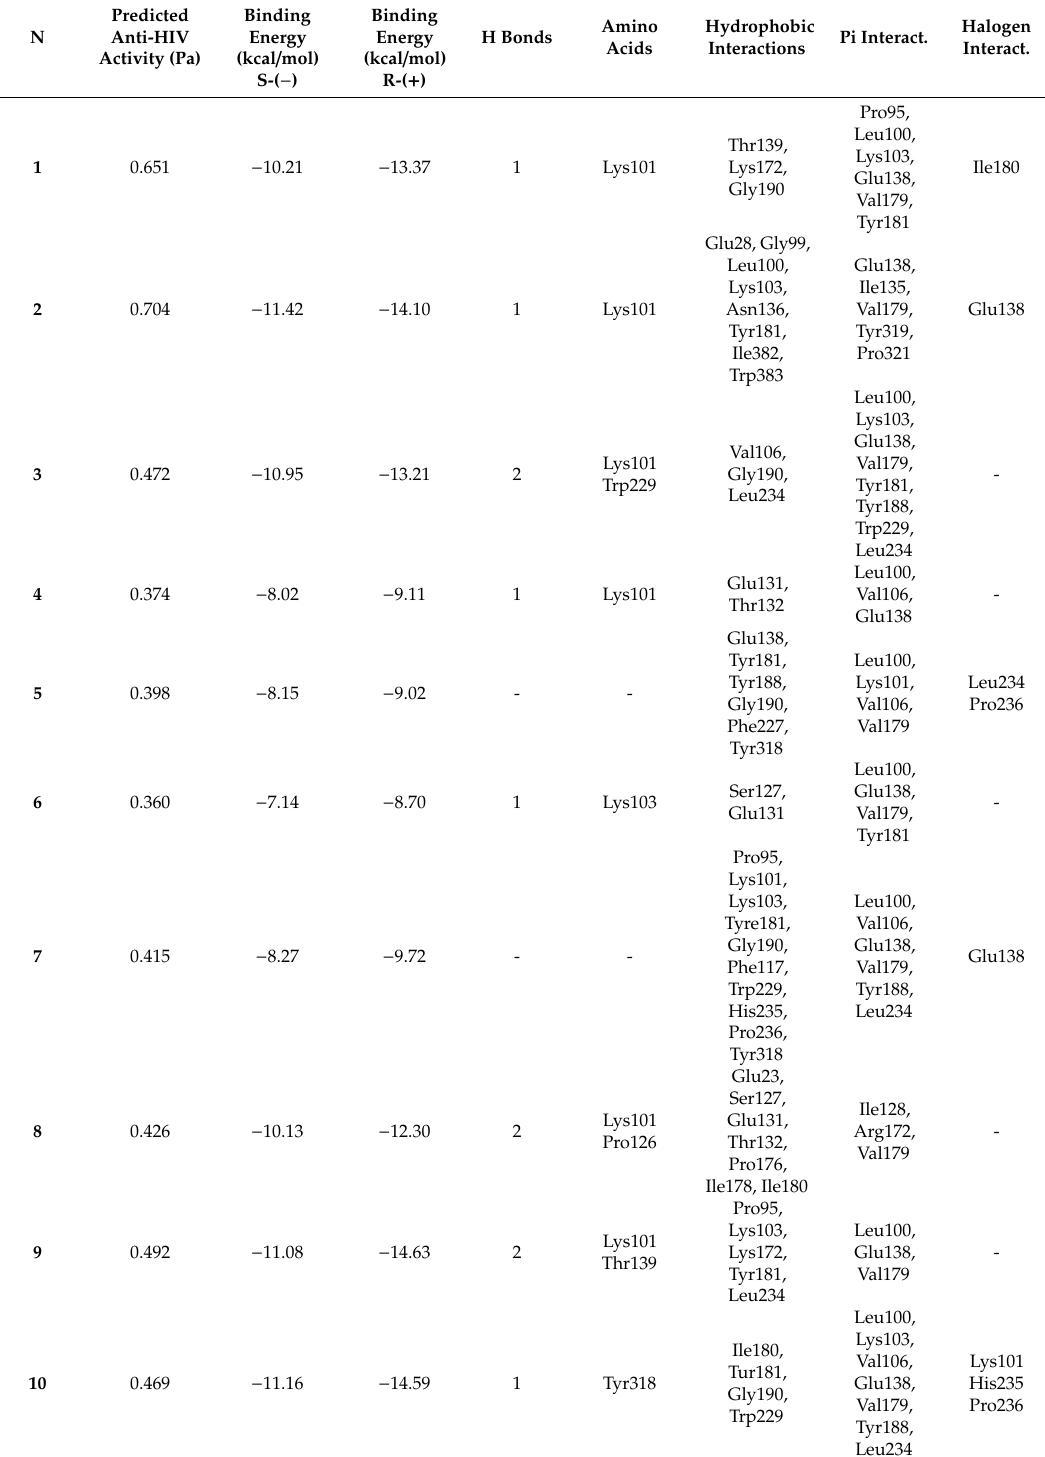
Table 2. Molecular docking scores and PASS prediction of the selected